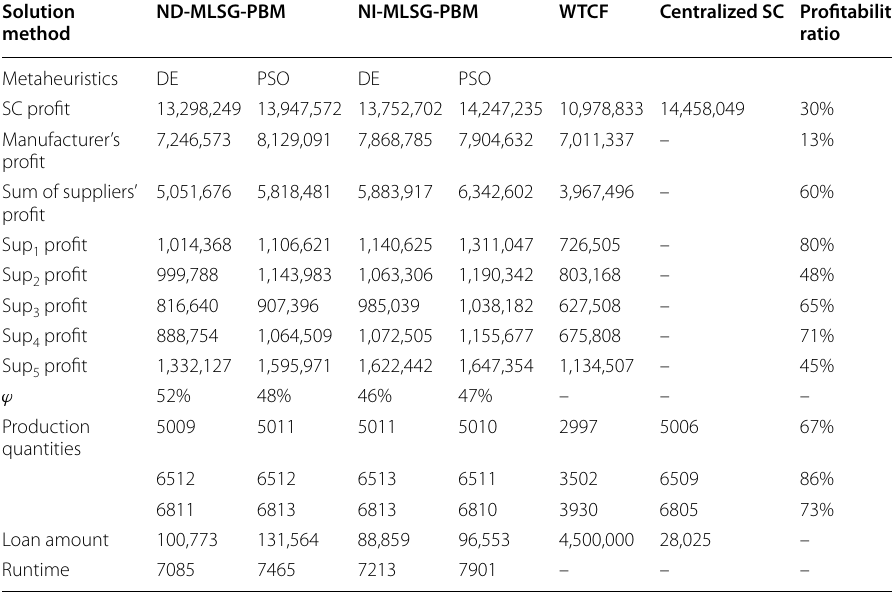
Table 5 A summary of the results for the TCFRS contract, WTCF case, and the centralized model for the test problems in size 1